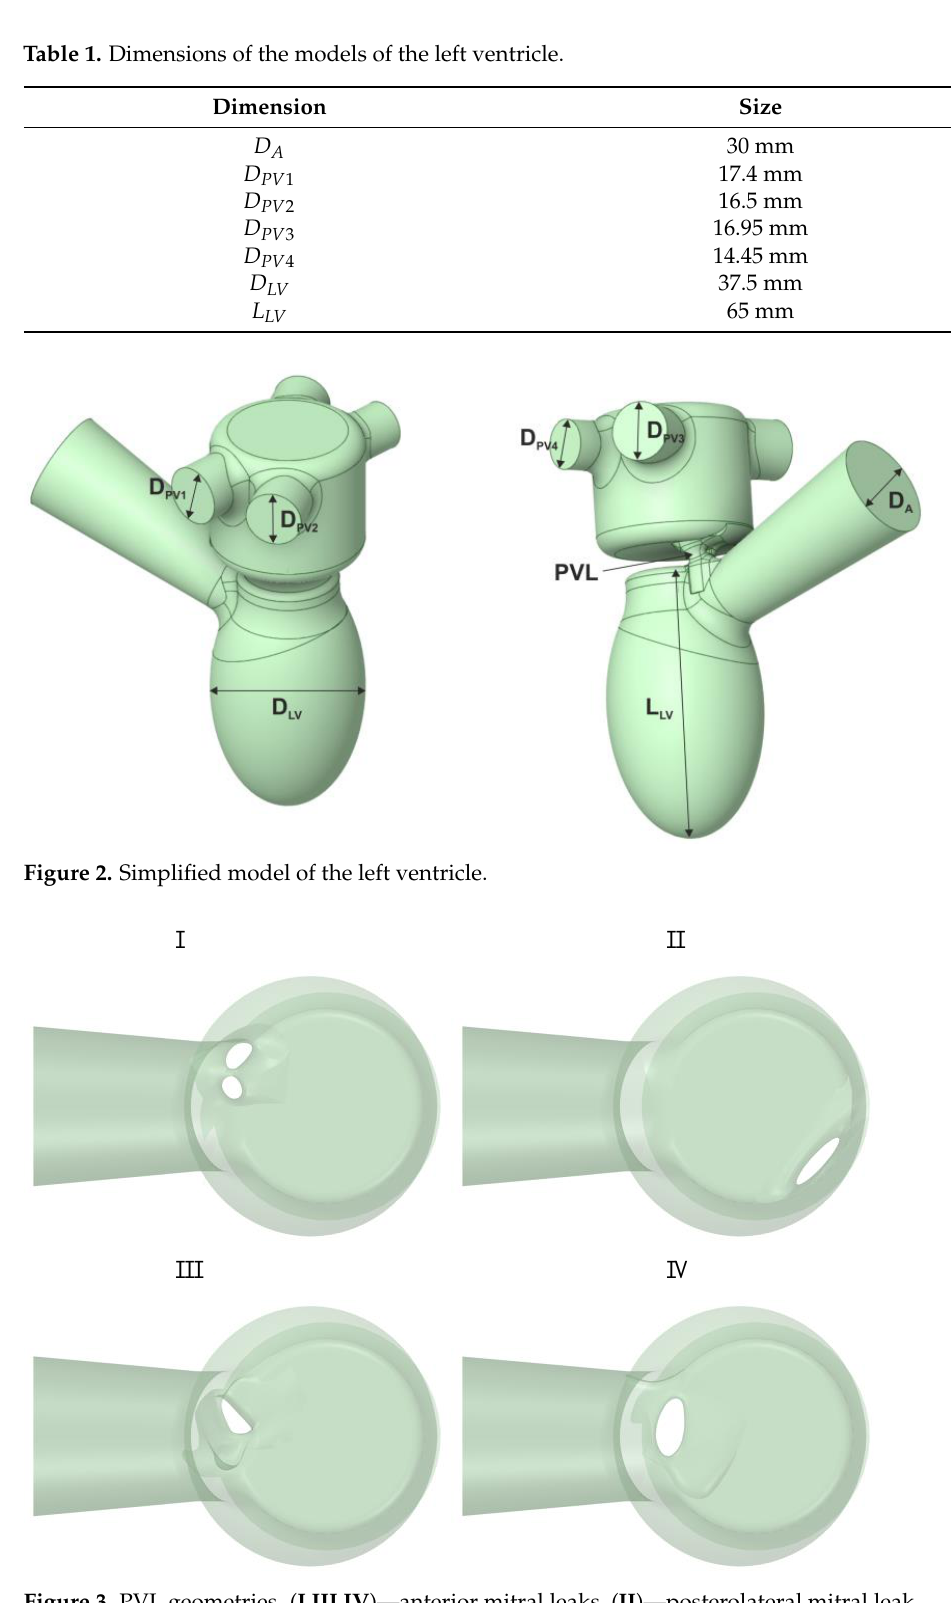
Figure 3. PVL geometries. ( I , III , IV )—anterior mitral leaks, ( II )—posterolateral mitral leak.